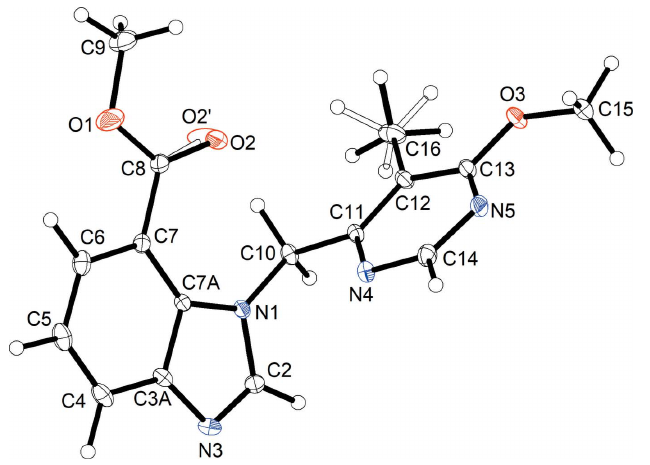
Figure 2 Displacement ellipsoid plot of 3 (50% probability level). Hydrogen atoms are represented by small spheres of arbitrary radius. Disordered parts with minor occupancy are drawn with empty bonds.